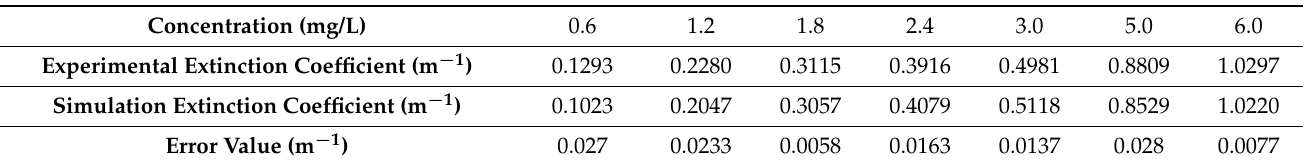
Table 11. A side ‐ by ‐ side table with experimental and simulated and error of extinction coefficients of the simulated seawater containing different suspended matter concentrations.